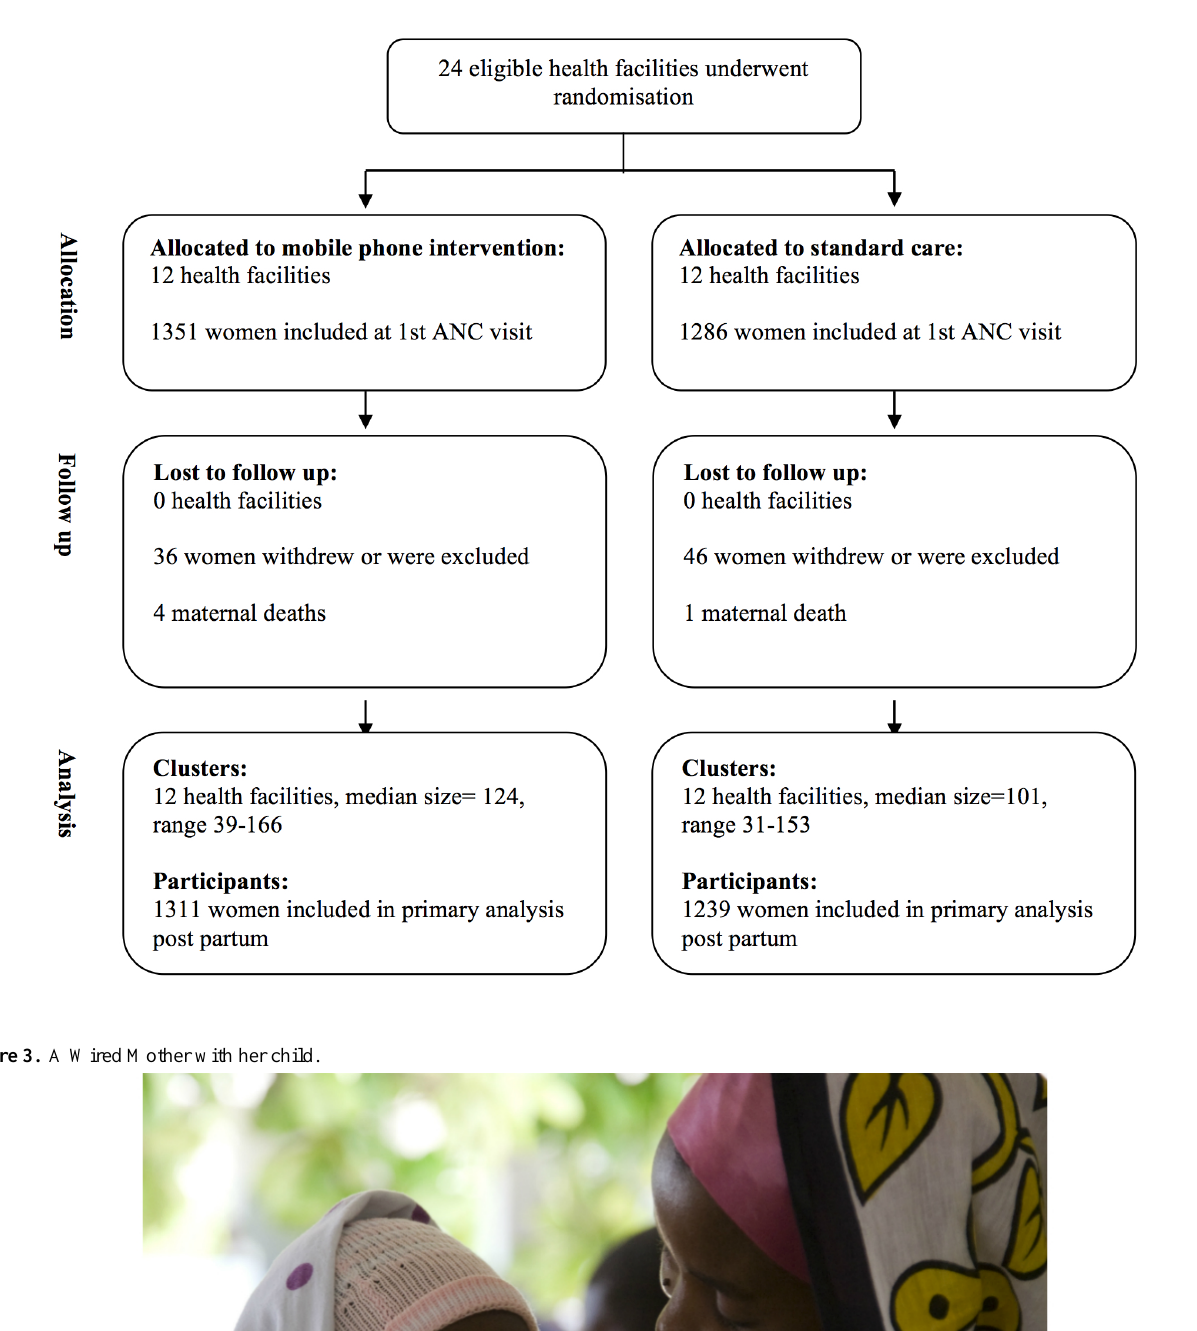
Figure 2. Procedures for the selection of the study population.